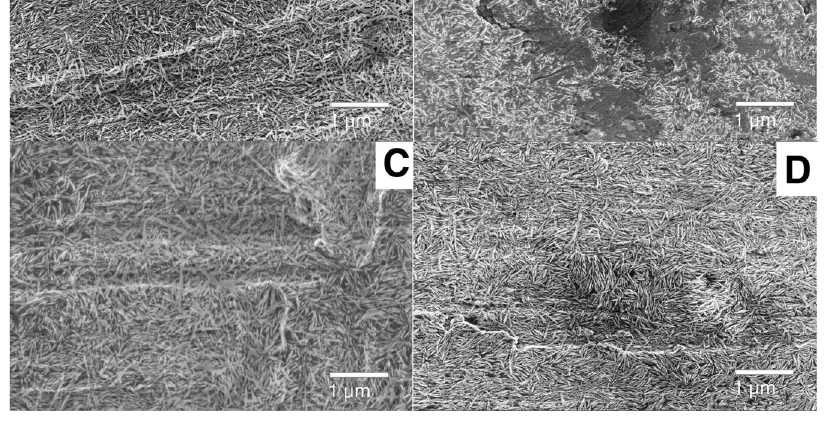
Fig. 9 SEM images of coated Ti surfaces prior to and after insertion in the skin: A Blasted Ti + HA before insertion, B Blasted Ti + HA after insertion, C Machined Ti + HA before insertion, D Machined Ti + HA after insertion